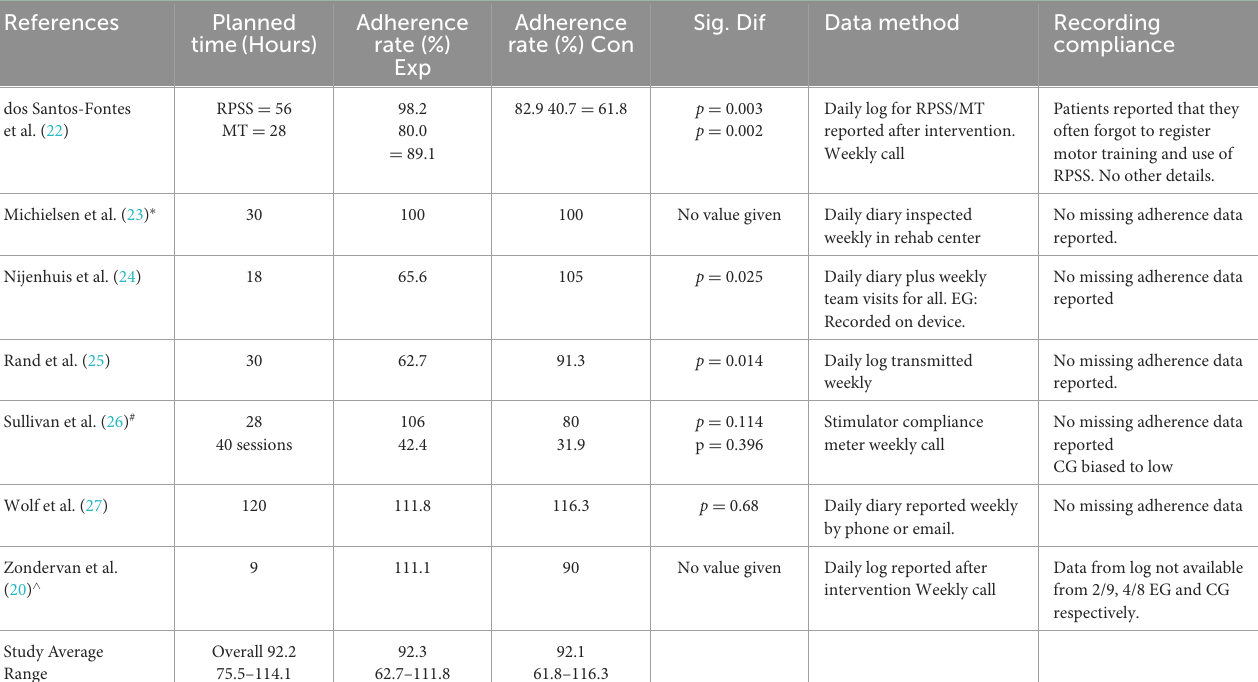
TABLE 4 Adherence to self-managed